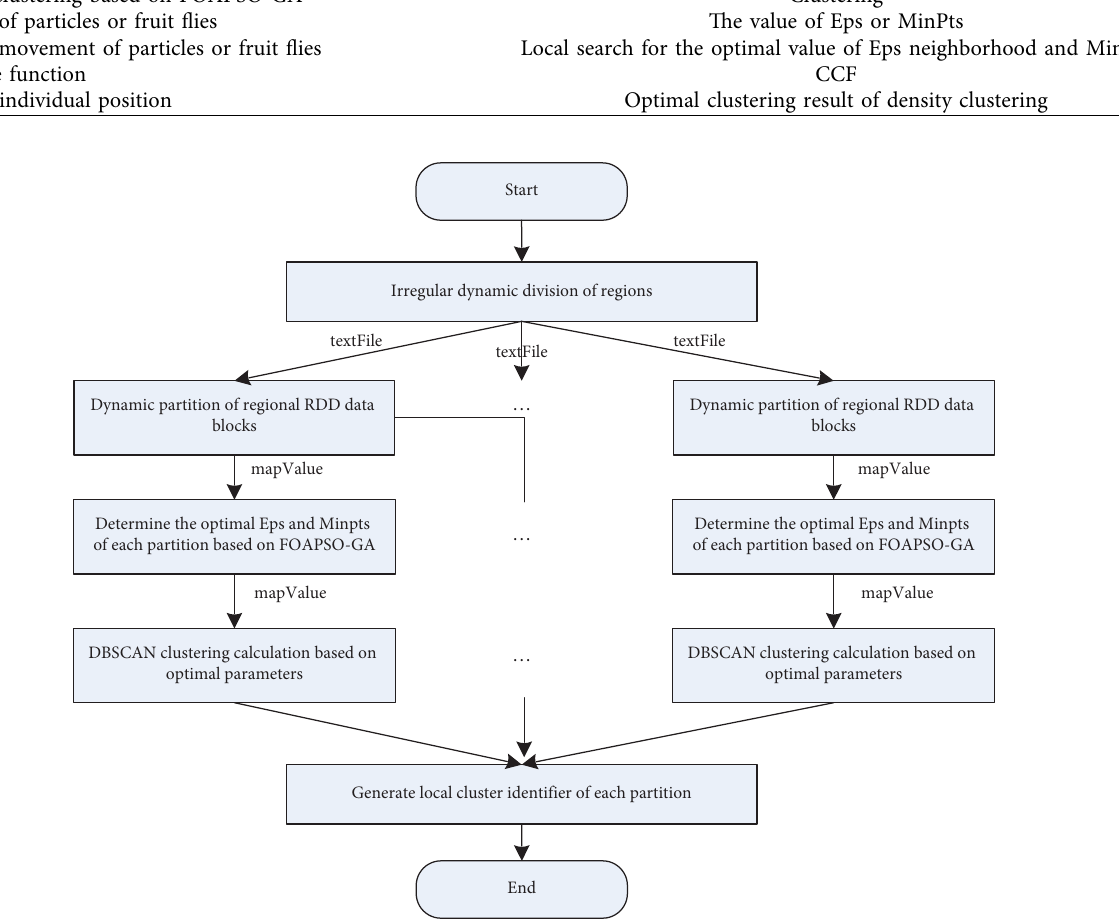
Figure 8: Parallelization process of local clustering. Table 2: Experimental data set. Table 3: Image dataset